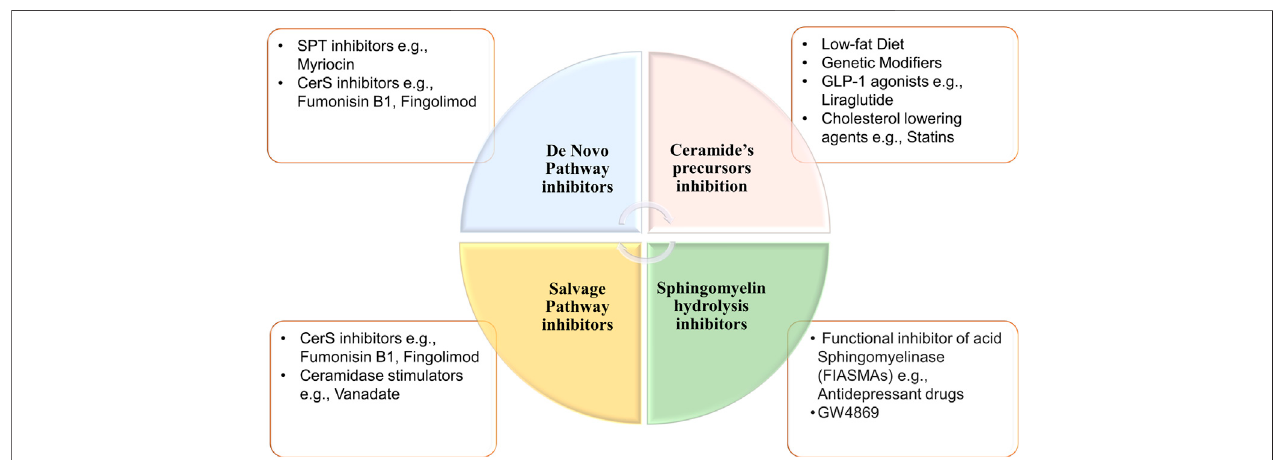
FIGURE 6 | Potential inhibitors of ceramides synthesis pathways. Ceramides can be synthesized through three different pathways. First, de novo synthesis pathway whichcanberepressedbyinhibitingceramidesynthasesorSPT.Secondsphingomyelinhydrolysispathway thatcanbeinhibited viafunctionalinhibitorofacid or neutral sphingomyelinase or Ceramides can be synthesized through three different pathways. First, De novo synthesis pathway which can be repressed by inhibiting ceramide synthases or Serine palmitoyl-transferase. Second, sphingomyelin hydrolysis pathway that can be inhibited via functional inhibitor of acid or neutral sphingomyelinase.Lastly,inhibitionofsalvagepathwaythroughdepletionofceramideprecursors(ceramidesynthasesinhibition),orviaincreasingceramidemetabolism by ceramidases. [CerS, ceramide synthases; SPT, serine palmitoyl-transferase].